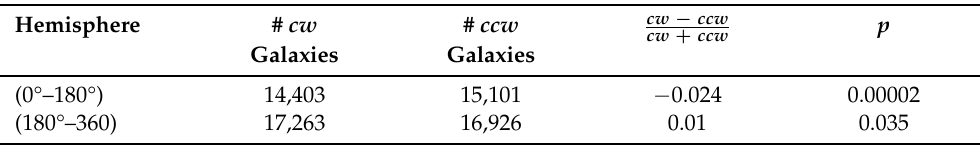
Table 4. Distribution of clockwise and counterclockwise galaxies in opposite hemispheres in SDSS. Most SDSS galaxies used in this study are in the Northern hemisphere.